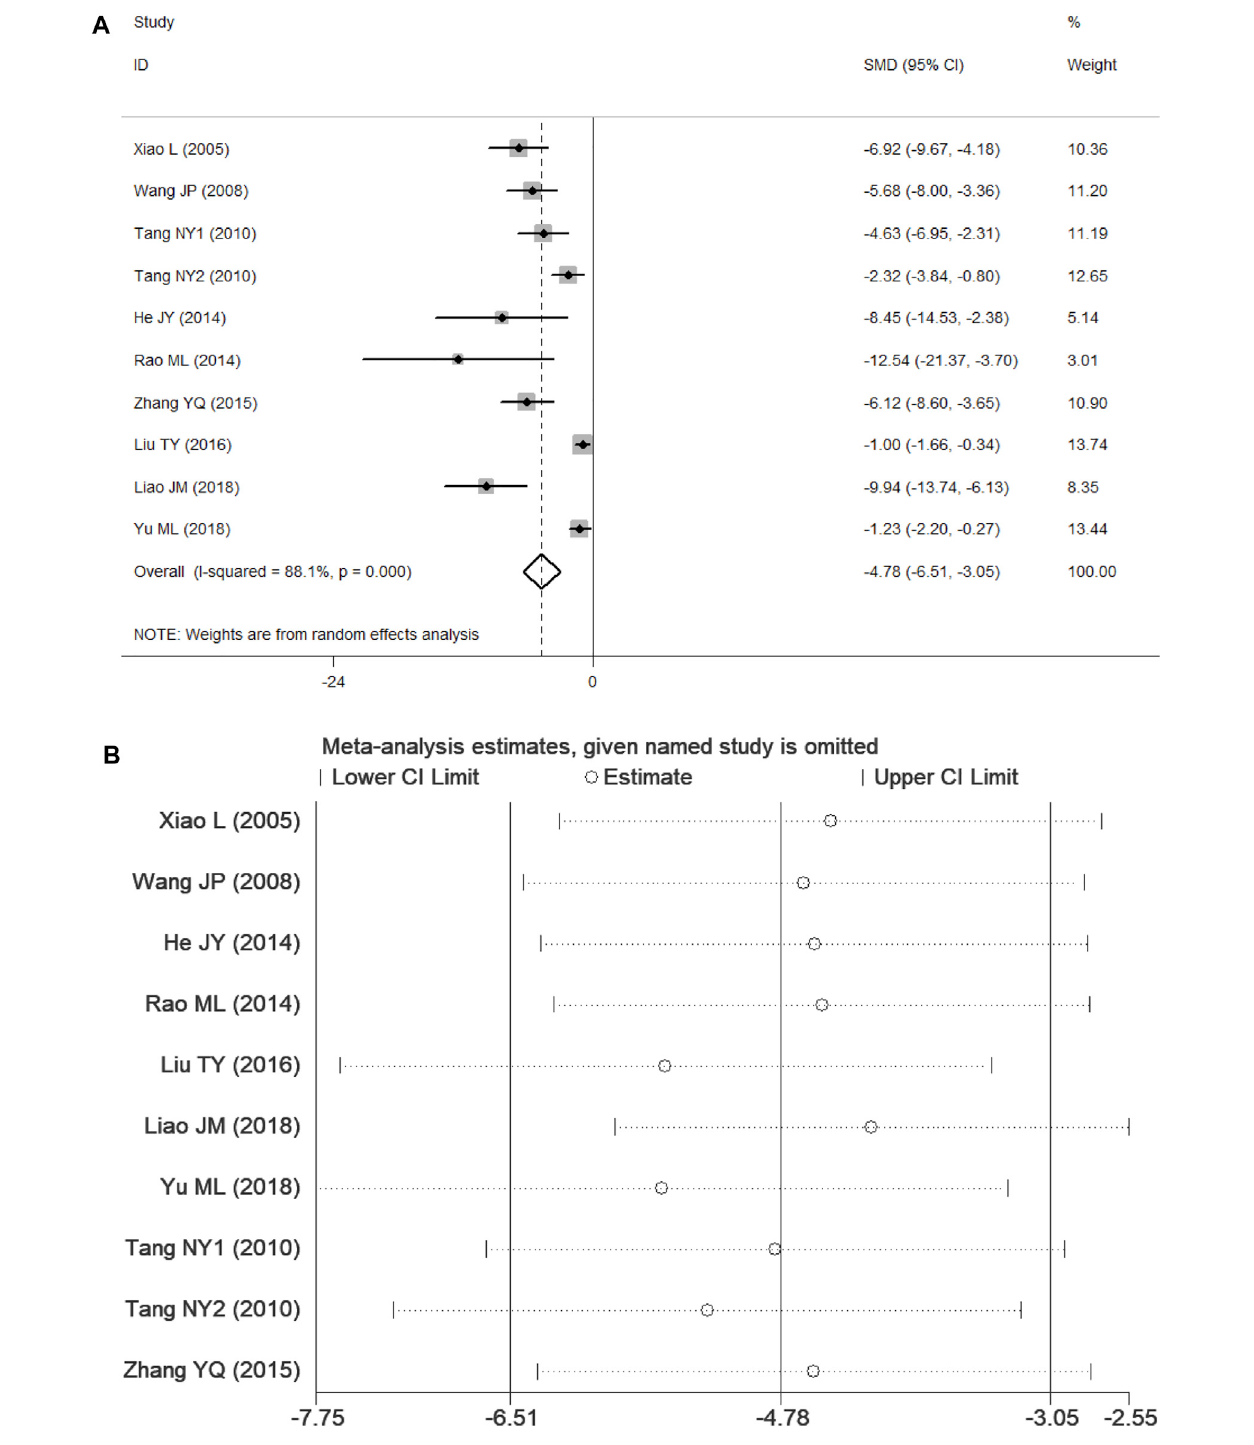
FIGURE 5 | Forest plots of PF for CIS. (A) Effects of PF on decreasing the CIS in comparison with the control group; (B) sensitivity analysis of PF for CIS.